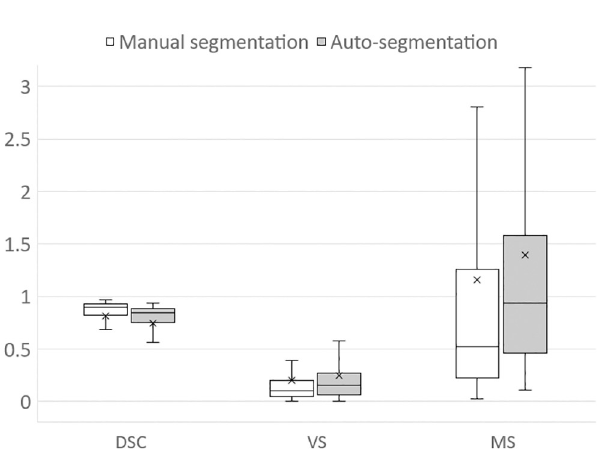
Fig 4. Comparison of segmentation similarity between two segmentation methods.